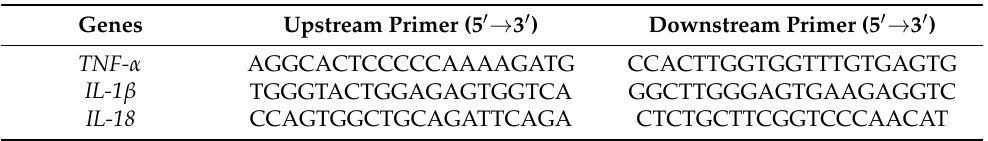
Table 1. Fluorescent quantitative PCR primer sequences. Genes Upstream Primer (5 (cid:48) → 3 (cid:48)